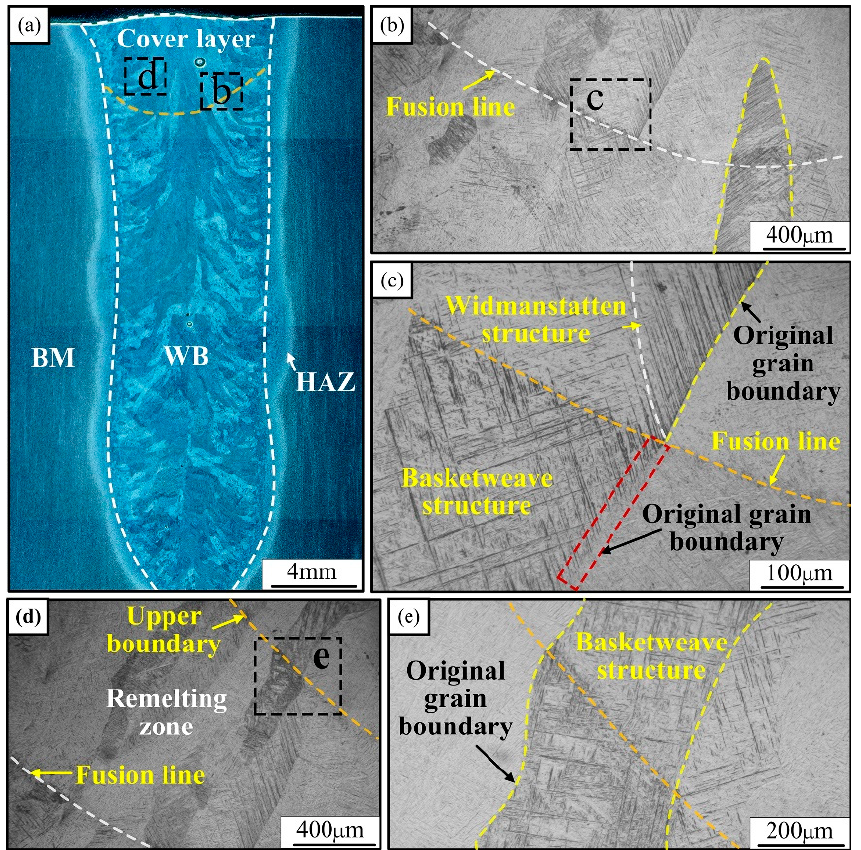
Figure 6. Microstructure of the upper interlayer weld area of the joint: ( a ) the joint cross-section, ( b , c ) the microstructure near the fusion line, ( d , e ) the microstructure near the upper boundary of the remelting zone.